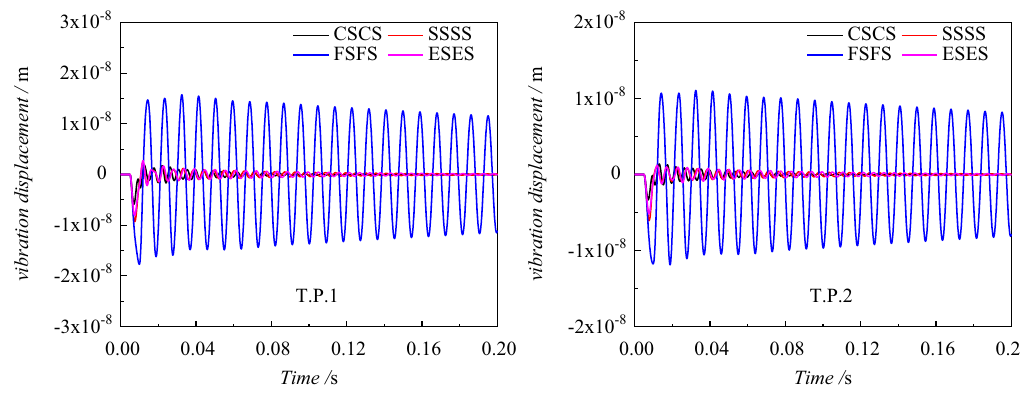
Figure 17: Comparison of the damped transient vibration response with di ff erent boundary conditions.